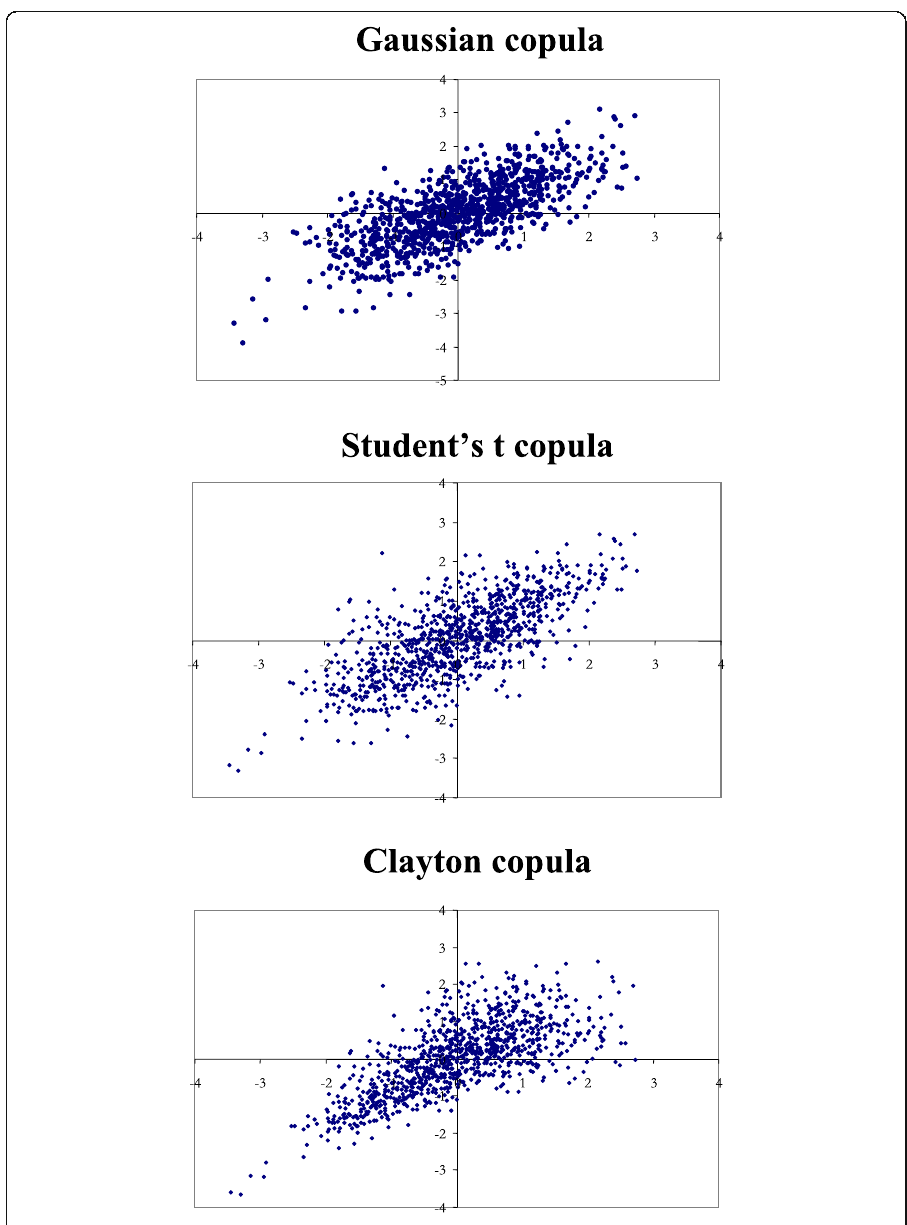
Fig. 2 Distribution of portfolio returns for a Gaussian, a Student t and a Clayton